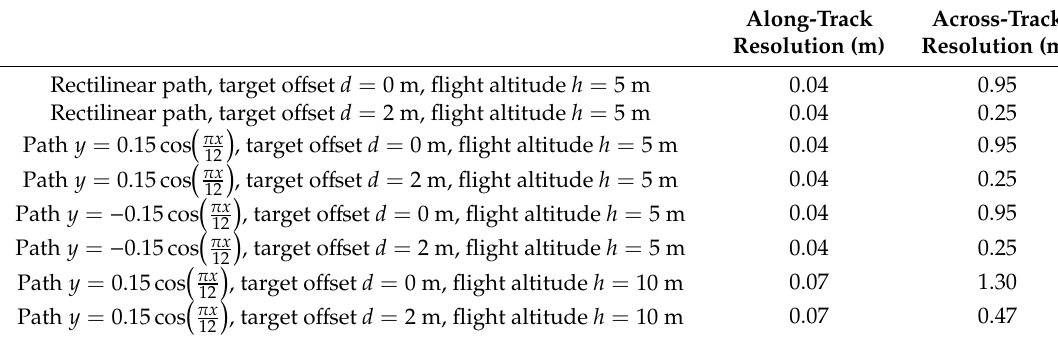
Figure 8. PSF amplitude for h = 10 m and a curved trajectory: ( a ) point like target at d = 0; ( b ) point like target at d = 2. The white dashed line shows the trajectory; the white circle denotes the target. Table 1. Along- and across-track resolution values.